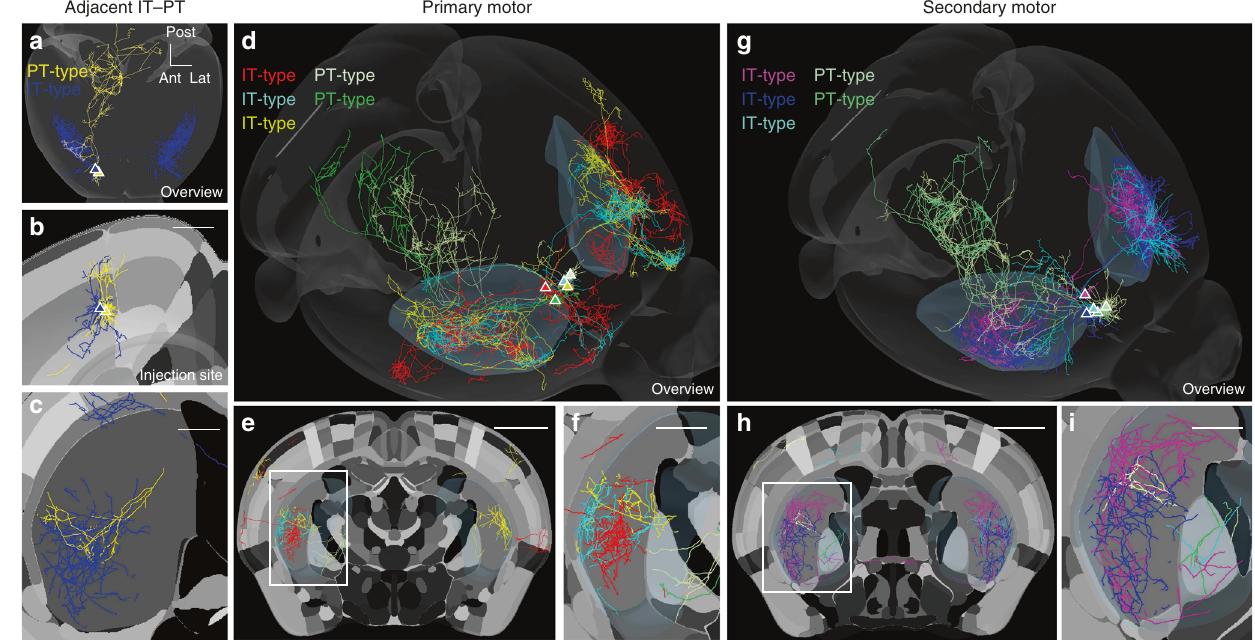
Fig. 7 Single neuron reconstructions of IT-type and PT-type neurons in motor areas. a Reconstruction of the long-range axonal projections of adjacent PT- type (gold) and IT-type (blue) L5 pyramidal neurons 34 . Projections throughout the whole CNS anterior to medulla are shown. The outline of the reference brain is shown. Scale, 1 mm. b Somata are in adjacent in primary motor cortex (M1). In coronal sections ( b , c , e, f , h , i ), the CCF reference atlas regions are shown in grayscale, with each area or cortical layer for a given cortical area shown in a distinct shade of gray. Scale, 0.5 mm. c Corticostriatal projections show similar general topography with differences in arbor size and density. Scale, 0.5 mm. d Five adjacent IT-type (red, teal, and gold) and PT-type (green and white) M1 neurons. PT-type neurons shown arborize in thalamus, superior colliculus, pons, and medulla in addition to ipsilateral striatum. The 3D outline of the reference brain is shown, with ipsi- and contralateral striatum highlighted in light gray. e , f Corticostriatal projections show topography of IT- type and PT-type projections, as well as differences in density, terminal fi eld size, and asymmetry of projections to contralateral striatum. White box in e magni fi ed in f . Scale, 1 mm ( e ), 0.5 mm ( f ). ( g – i ) Five adjacent IT-type (purple, teal, and blue) and PT-type (green and off-white) secondary motor cortex (M2) neurons. Scale, 1 mm ( h ), 0.5 mm ( i